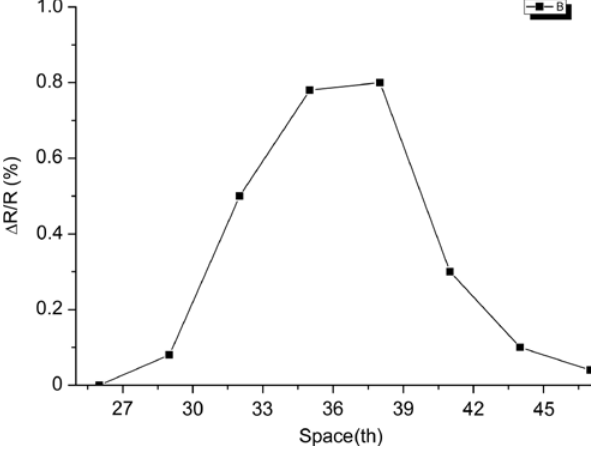
Figure 10: Damage exists at columns 2, space = 38, a =